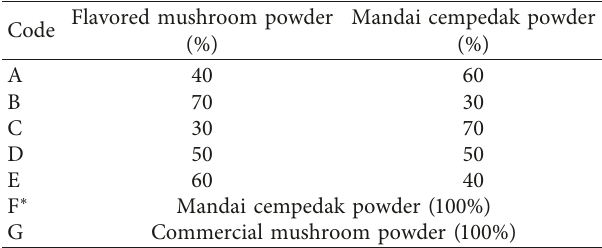
Table 1: Composition of flavored mushroom powder and mandai cempedak powder. Flavored mushroom powder Code